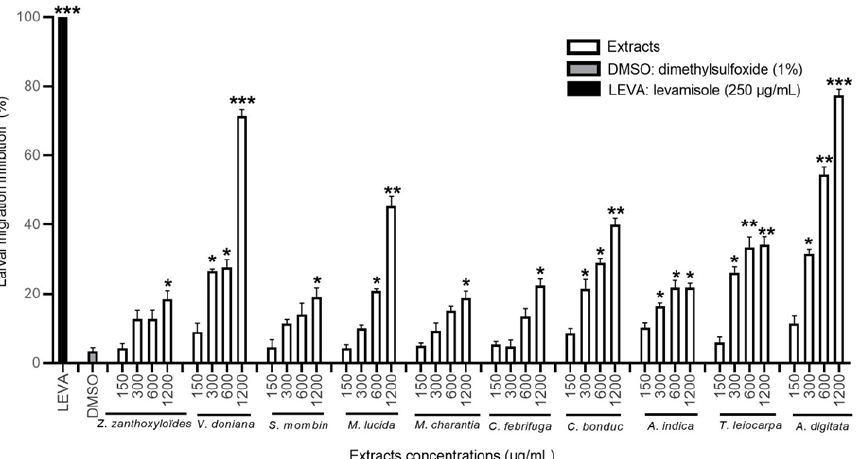
Figure 6. Migration inhibition rate (in %) of H. contortus larvae treated with aqueous extracts at different concentrations, DMSO, and levamisole. Asterisks indicate a significant difference compared to the negative control (DMSO) (* p < 0.05, ** p < 0.01, *** p < 0.001). Each histogram represents the mean ± standard deviation from 3 × 3 values.